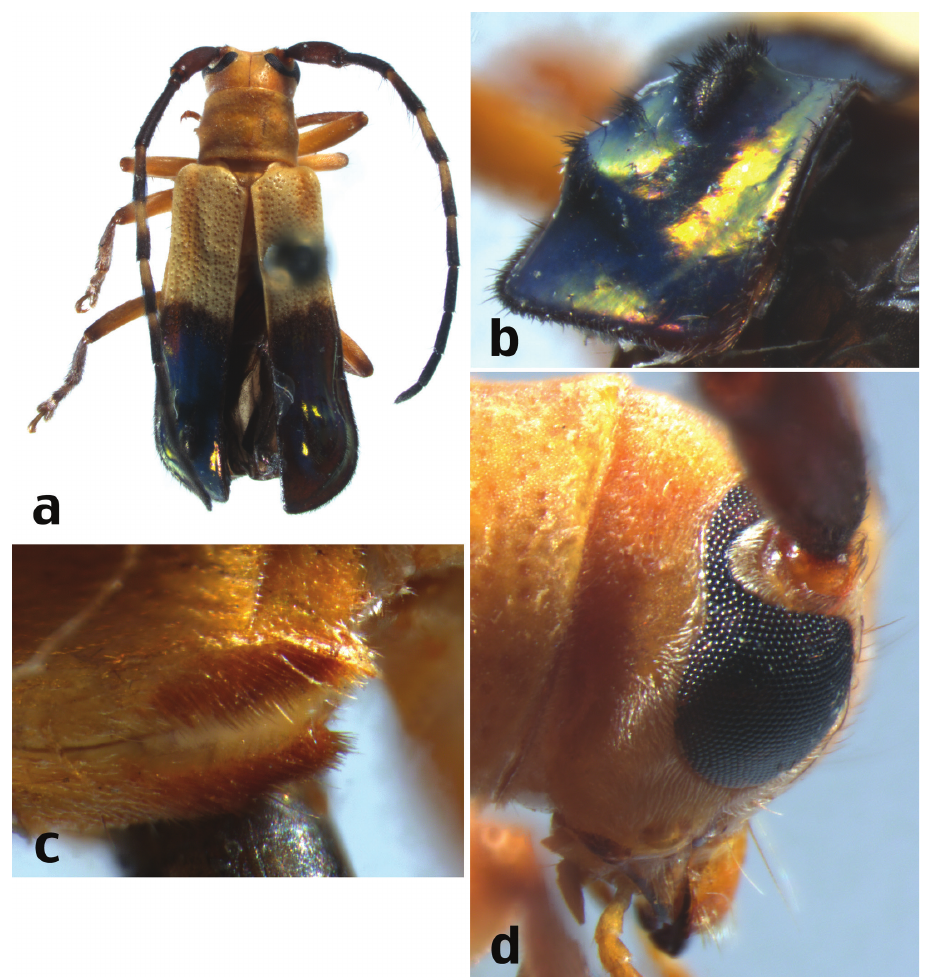
Figure 4. Calocosmus contortus Lingafelter, sp. n., holotype: a dorsal habitus b elytral apex c metasternal pubescent tufts d lateral view of